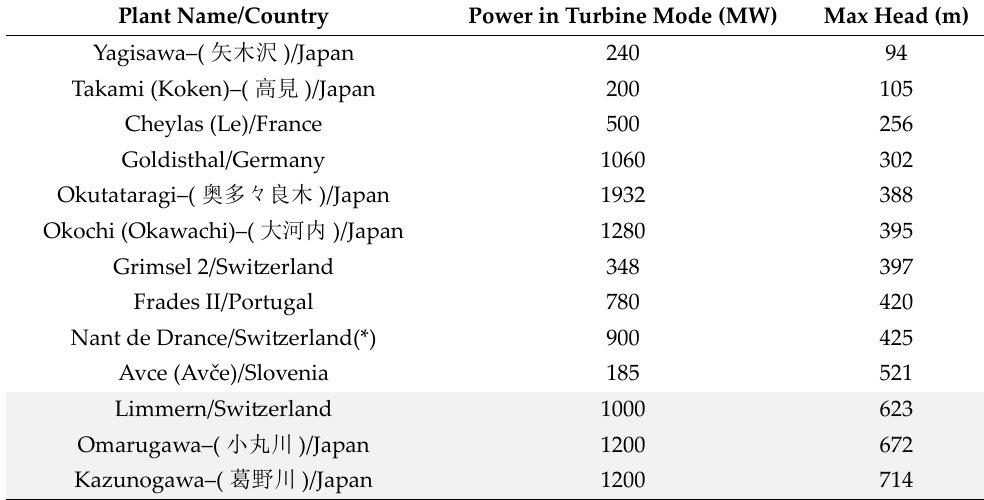
Figure 5. Diagram of flow rate over the head for the most common hydraulic turbines. Table 2. Variable‑Speed Pumped Storage Plants presently in operation at the global level. Japanese names of plants in Japan are presented as a reference within brackets. Gray cell background is for plants whose maximum head is beyond 600 m. (*) Nant de Drance was commissioned in July 2022.